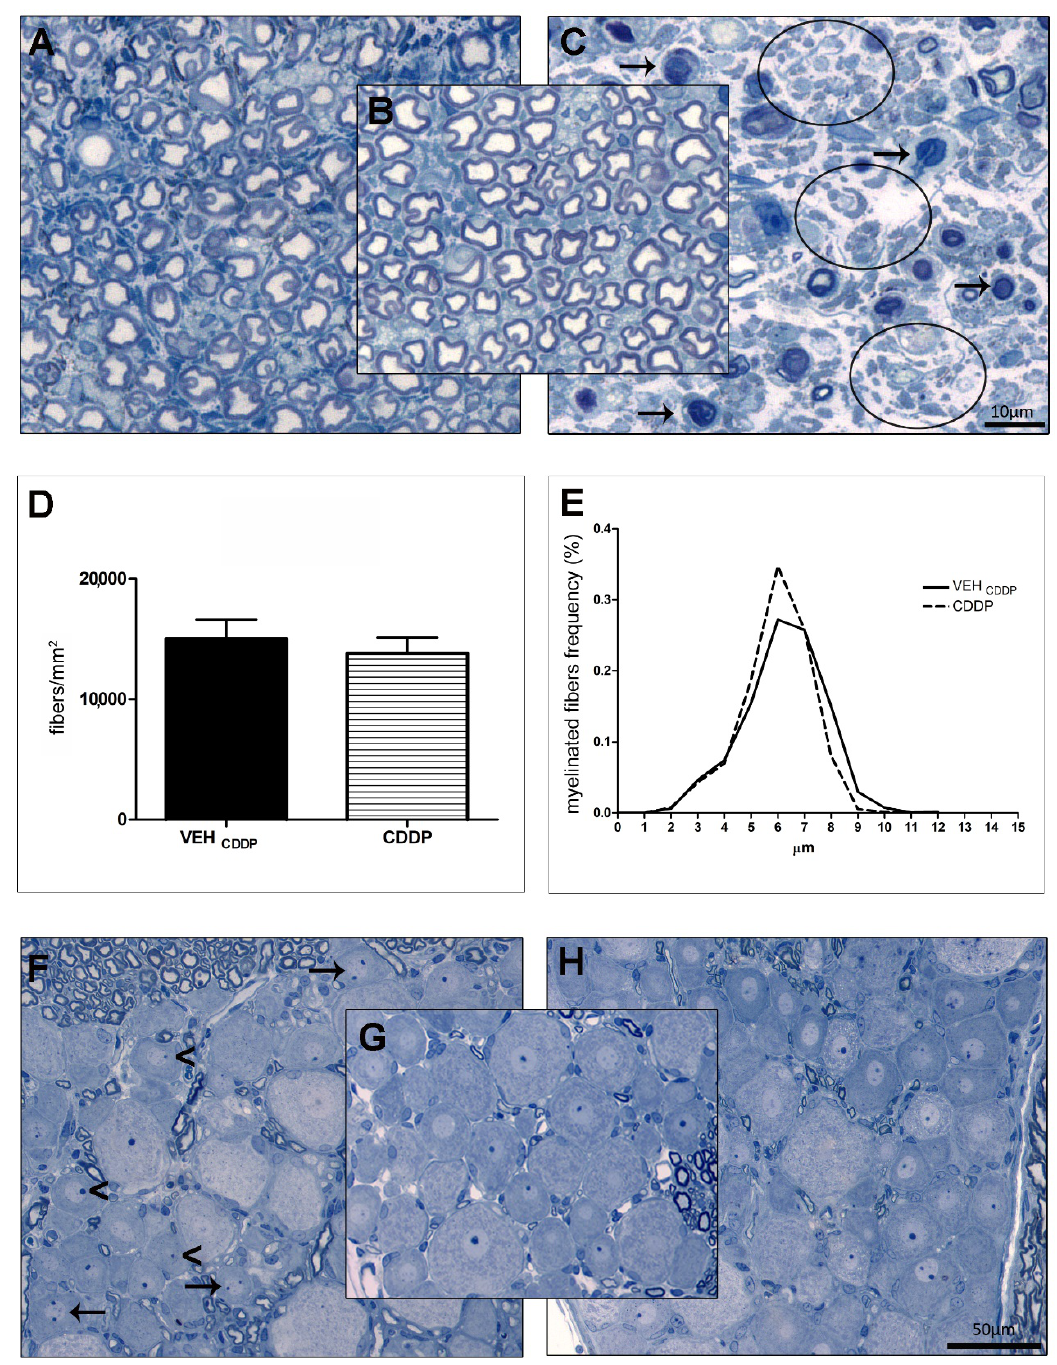
Figure 1. Morphological and morphometric analysis of caudal nerves and DRG. ( A – C ): representative images of caudal nerves at light microscopy; ( A ): cisplatin; ( B ): vehicle; ( C ): paclitaxel; ( D , E ): mor- phometric analysis of caudal nerves; ( F – H ): representative images of DRG at light microscopy; ( F ): cisplatin; ( G ): vehicle; ( H ): paclitaxel. Arrows and circles in ( C ) represent fiber degeneration and loss, respectively. Arrows and arrowheads in ( F ) indicate multinucleolarity and nucleolar eccentricity, respectively.